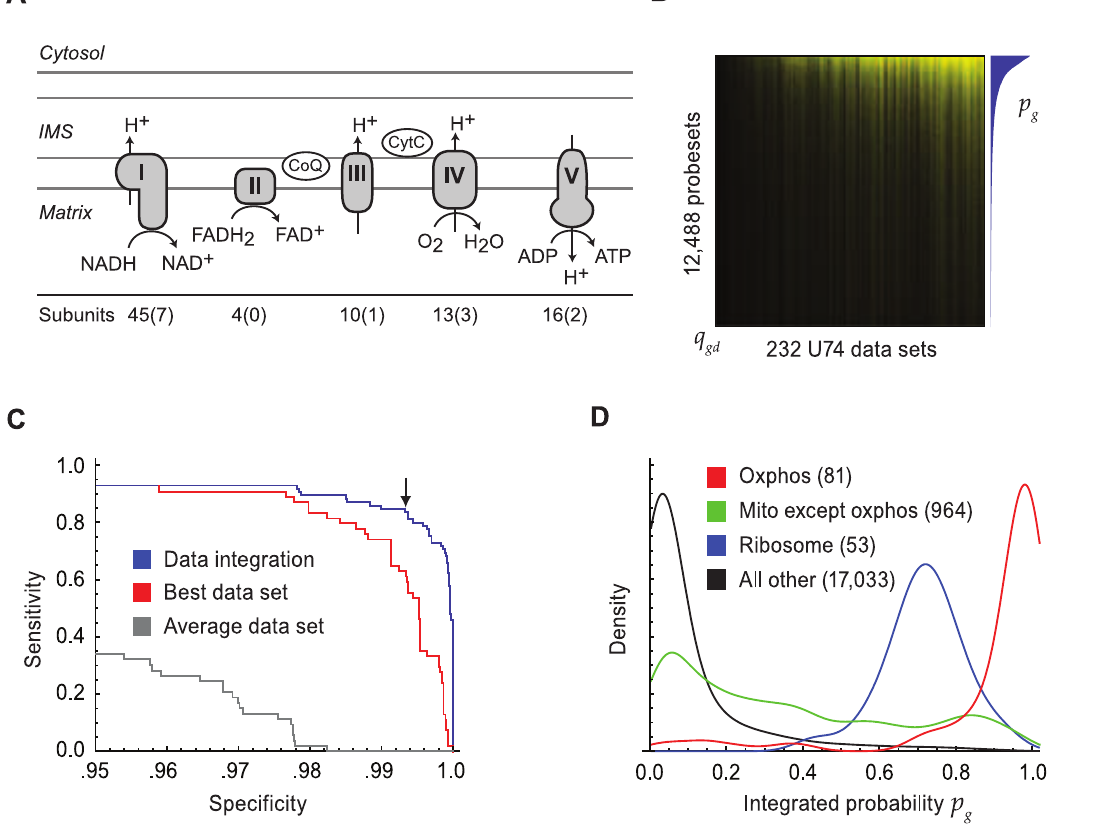
Figure 2. The OxPhos expression screen. (A) A schematic overview of mitochondrial OxPhos. The total number of protein subunits comprising each complex is noted below the schematic. The number of subunits encoded by mitochondrial DNA that were excluded in the OxPhos expression screen is indicated in parentheses. (B) Co-expression matrix from the OxPhos expression screen for the mouse MG-U74Av2 chip. Each value in the matrix represents a gene’s (rows) co-expression with OxPhos within a microarray data set (columns). (C) Cross-validated receiver-operator curve reporting the recovery of the query OxPhos genes. Blue line: full expression screen data integration (1,427 data sets). Arrow marks the 99.4% specificity threshold recovering 85% of the OxPhos query genes. Red line: the single best data set. Gray line: a data set with median weight. (D) Histogram of integrated co-expression probabilities from the OxPhos expression screen. Red line: OxPhos query gene set. Green line: non-oxphos mitochondrial genes. Blue line: cytosolic ribosome genes. Black line: all other genes.